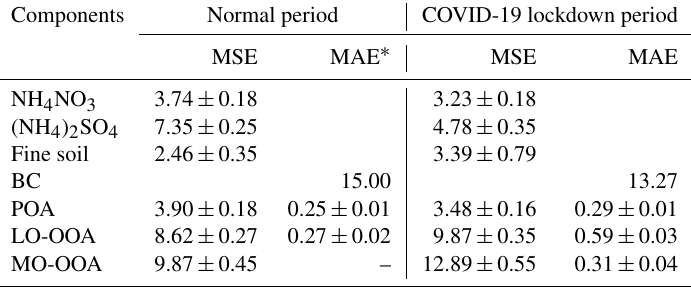
Table 2. Estimated MSEs and MAEs (m 2 g − 1 ) of individual chemical components during the normal and COVID-19 lockdown periods.